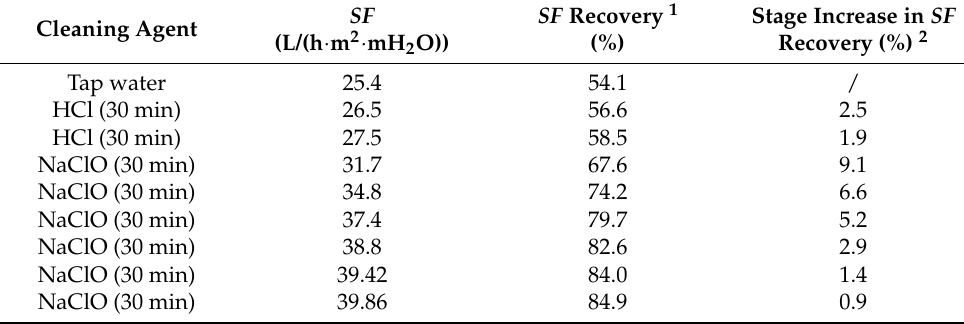
Table 3. SF recovery for physical and chemical